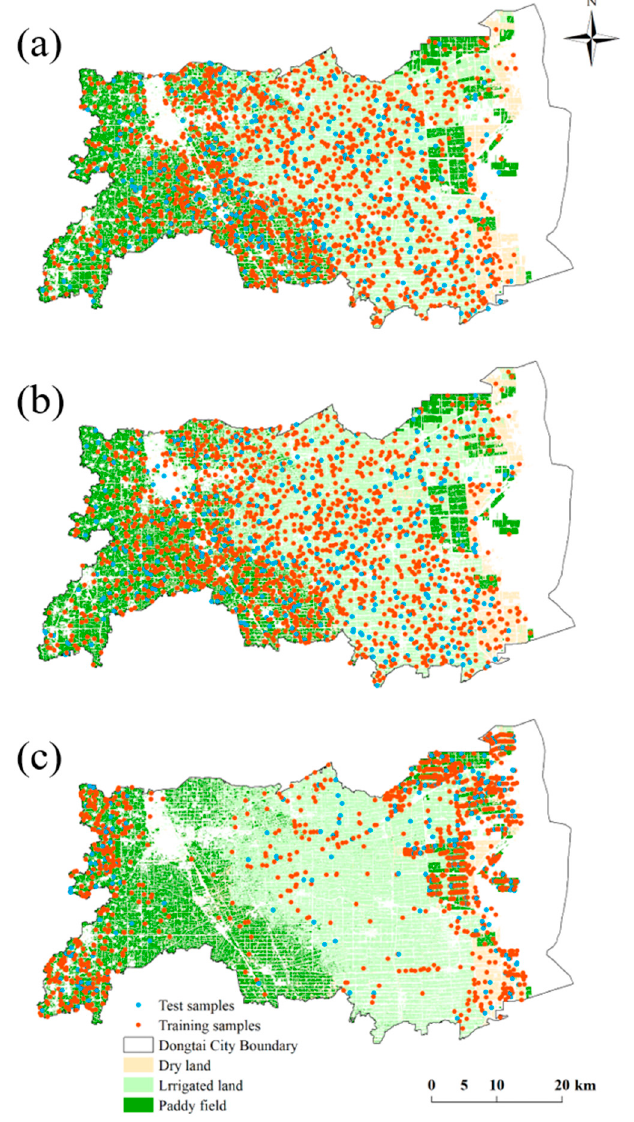
Figure 3. Map showing the distribution of three samples. ( a ) RPO samples, ( b ) RPA samples, ( c ) ASP samples.